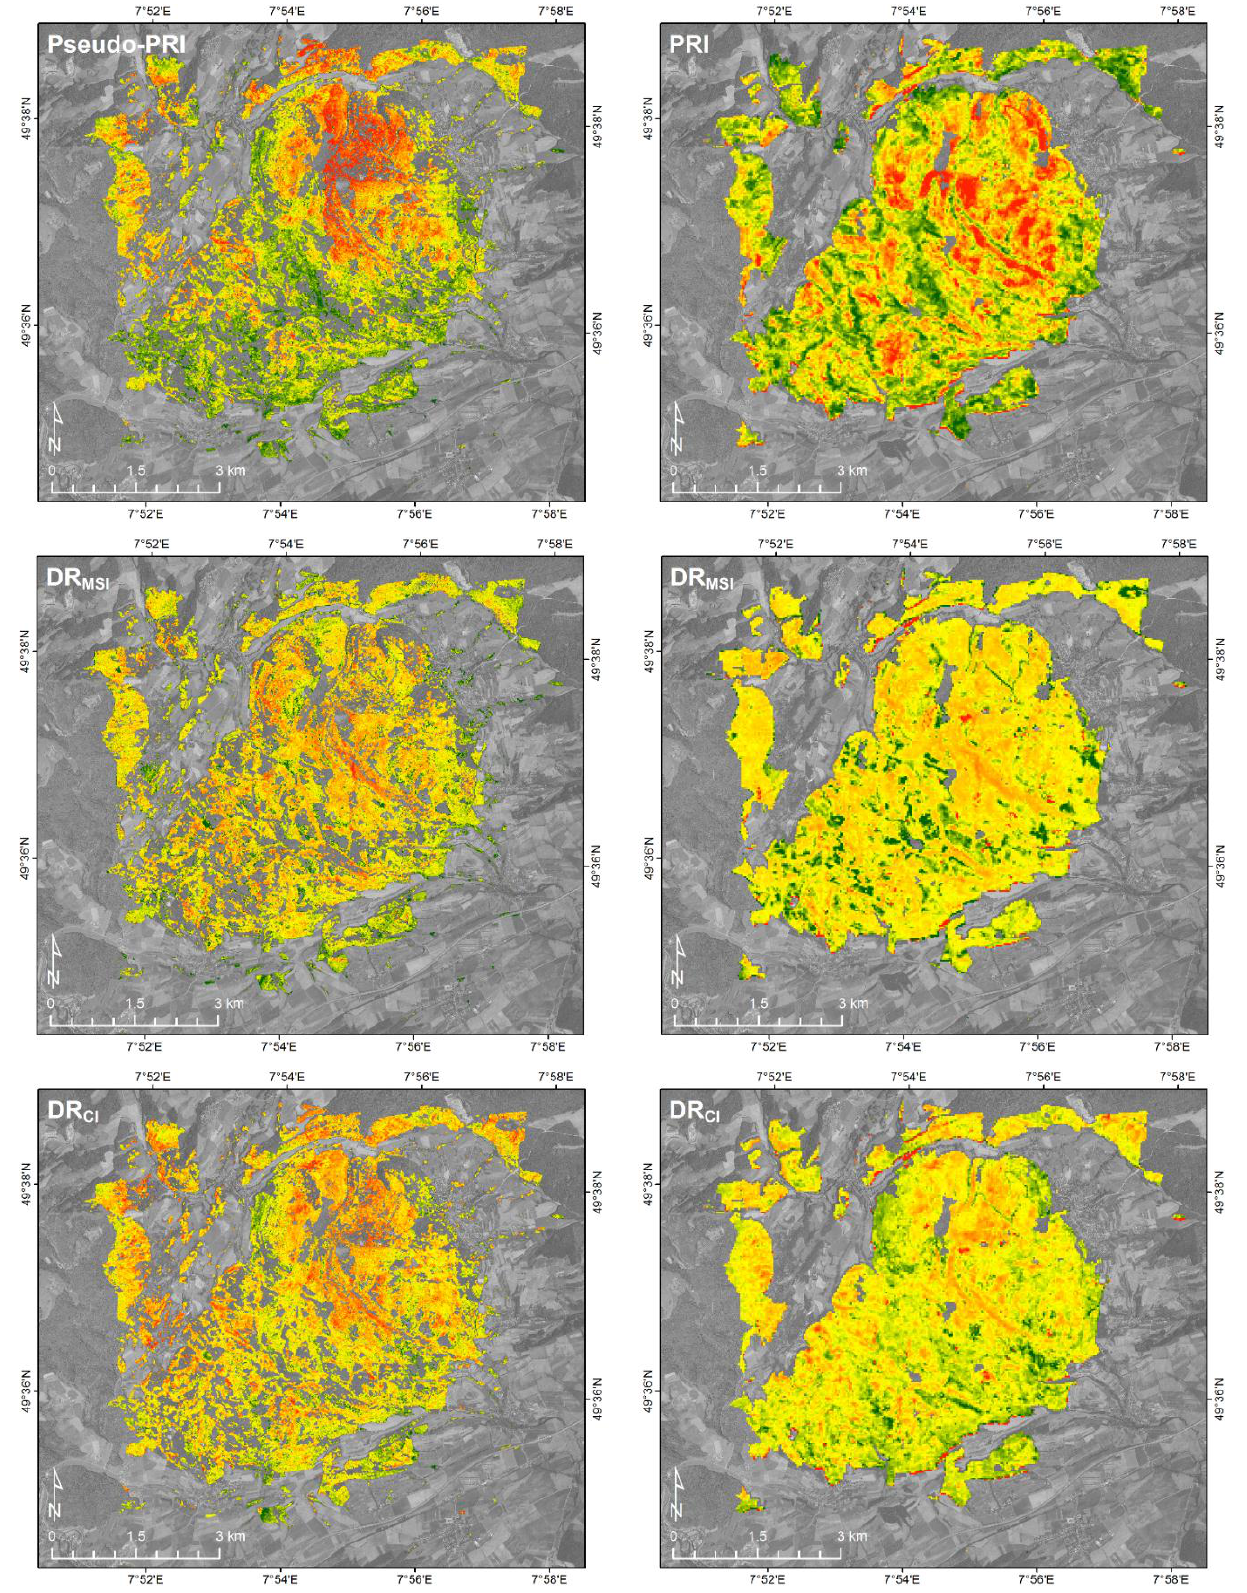
Figure 13. Maps of “pseudoPRI”, DR MSI and DR CI from simulated Sentinel-2 data ( left ) and the corresponding indices (PRI, DR MSI and DR CI ) from simulated EnMAP data ( right ). All maps are colored from red (mean – 2 standard deviations) to green (mean + 2 standard